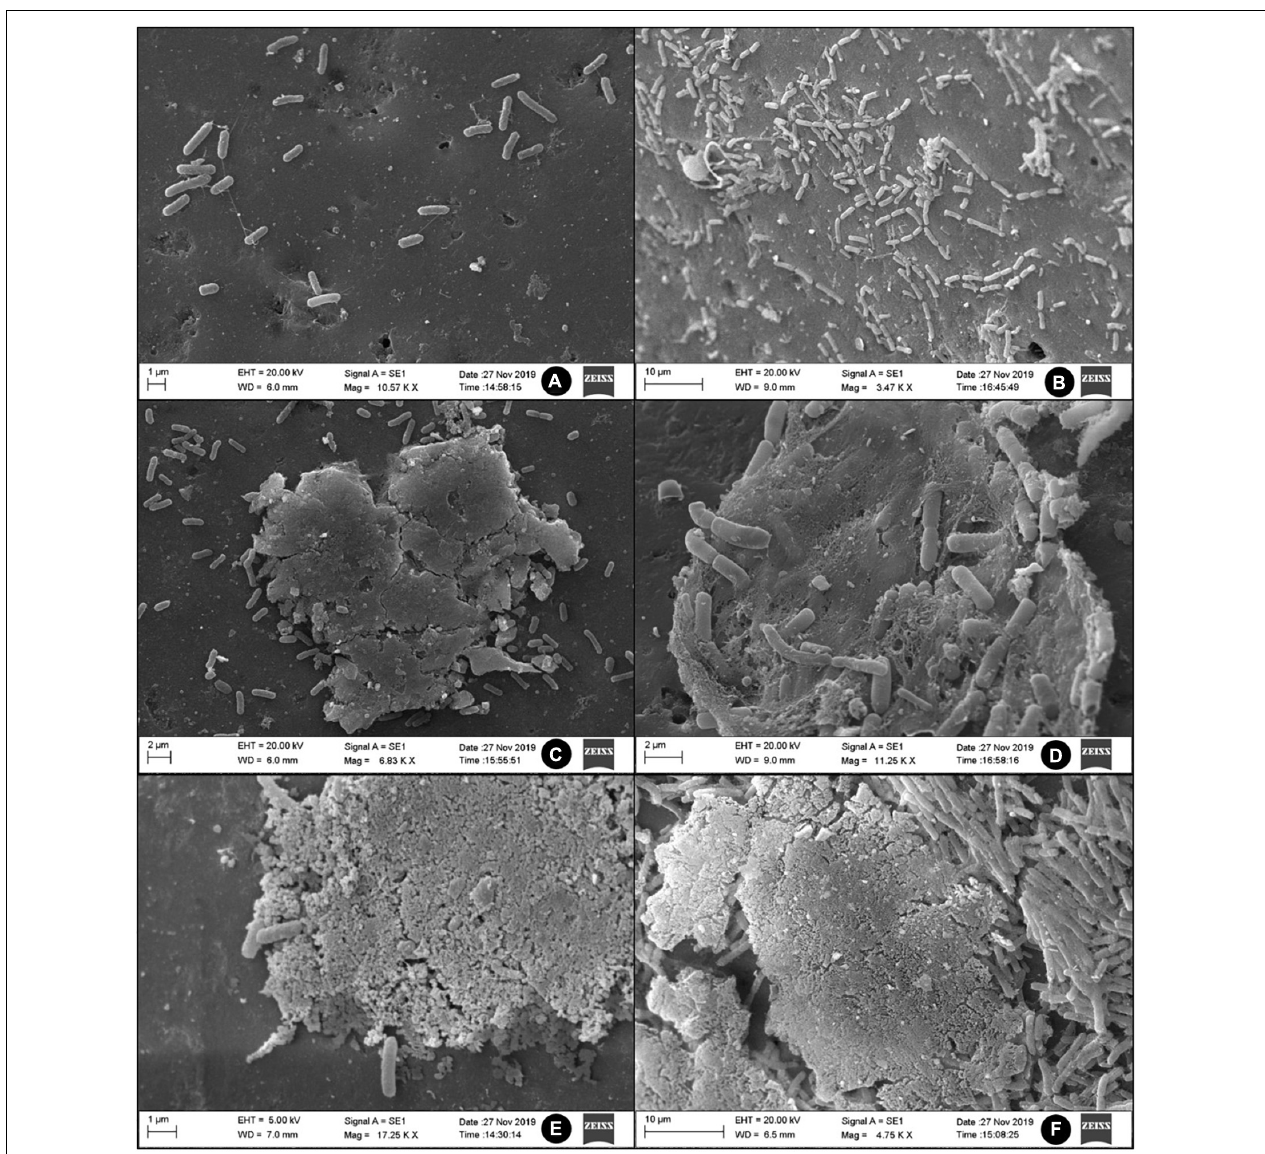
FIGURE 2 | SEM images of two strains of S H at temperatures of 4 (A,B) , 25 (C,D) , and 37 ◦ C (E,F) in TSB.